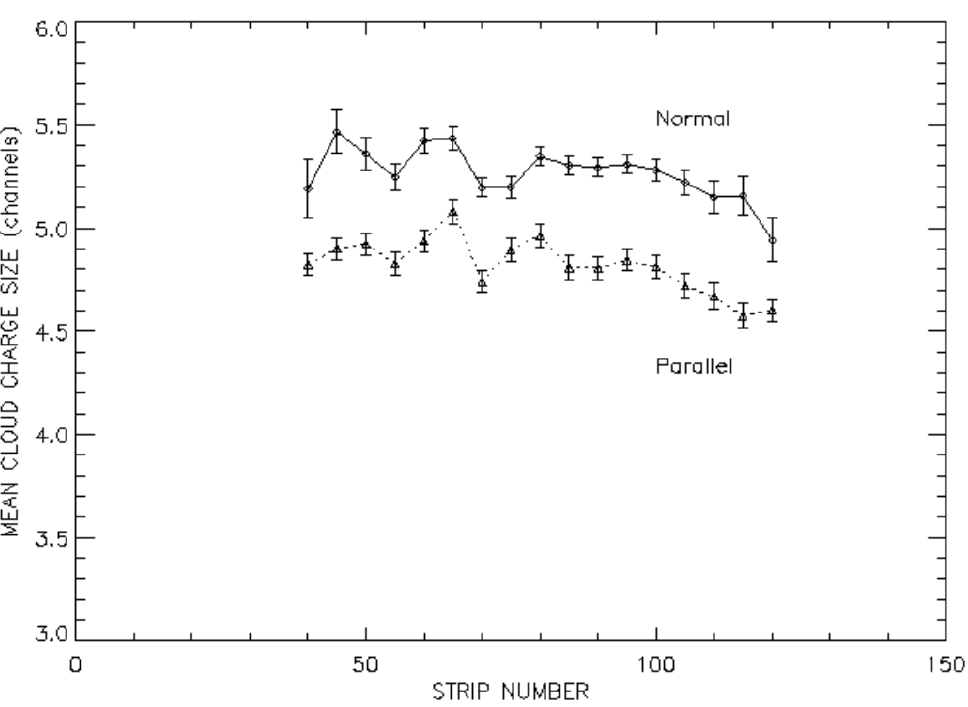
Figure 2. The first detection of the effect of polarization by the Pisa and Roma teams with a micro-gap detector filled with a Ne-Dimethyl Ether (DME) mixture. The tracks produced by photoelectrons created by photons polarized perpendicular to the strips are definitely longer than those created by photons polarized parallel to the strips. The pitch of the strips is 200 µ m. The figure shows that the effect is the same through the whole